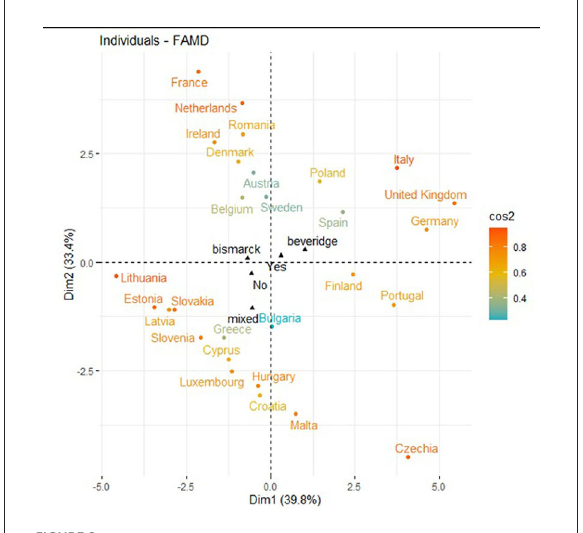
FIGURE8 Distribution of the countries between dimension 1 and dimension 2.